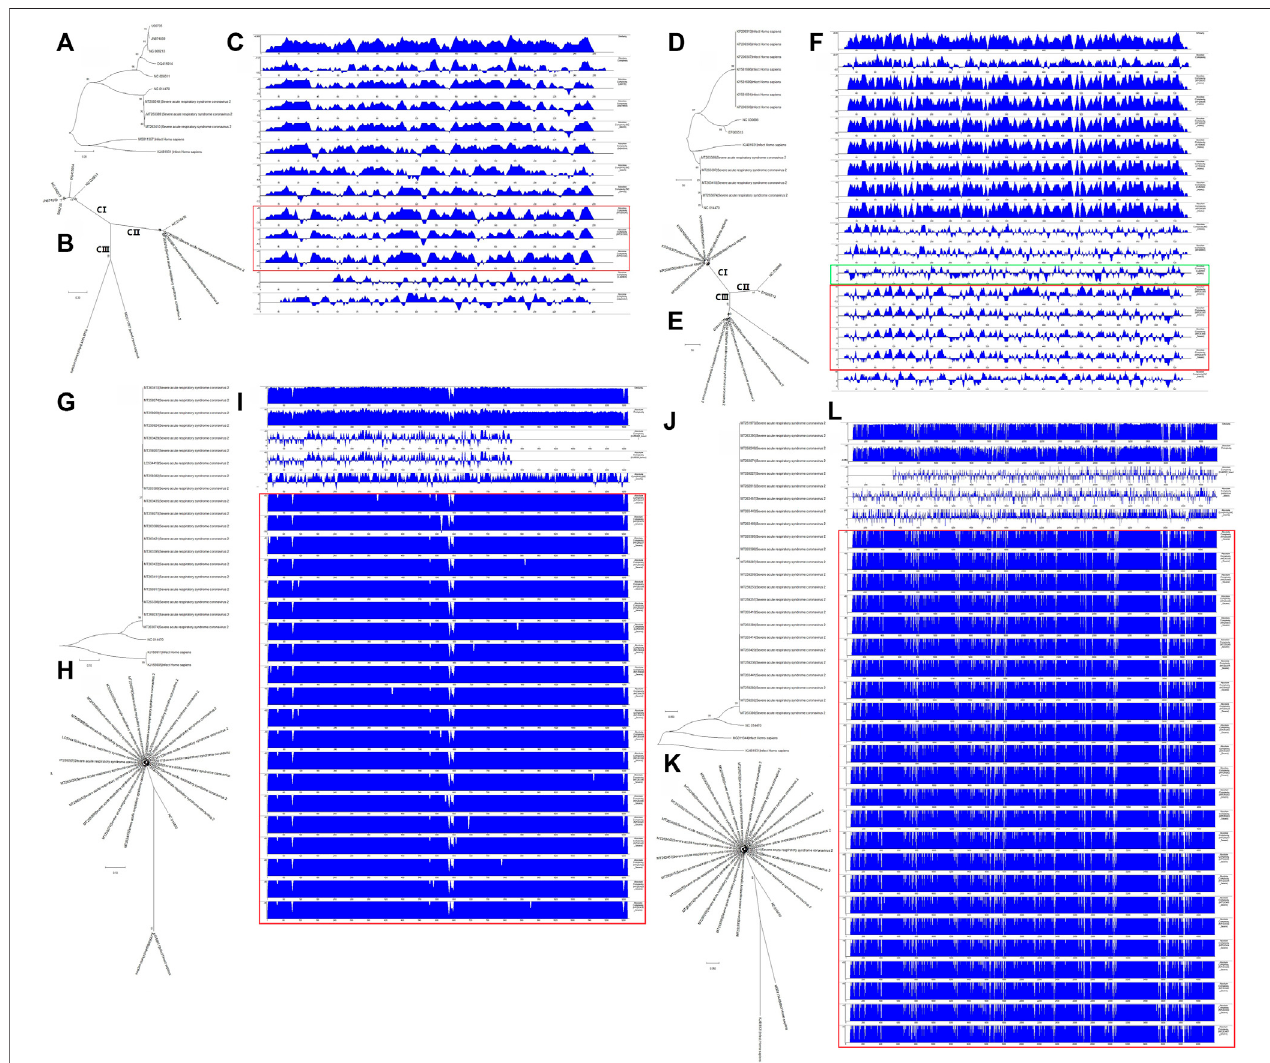
FIGURE5| Evolutionarycharacteristicsandabsolutediversitiesofstructuralgenesofsevereacuterespiratorysyndromecoronavirus-2(SARS-CoV-2)isolatesand commoncoronaviruses(C-CoVs). (A,B,D,E) :TheEand Mgenesequences ofSARS-CoV-2 isolatesandcommonCoVs couldbe grouped intothreeclades (CI, CIIand CIII). A, B: The E gene sequences of SARS-CoV-2 isolates and C-CoV NC014470 were evolutionary intermediates between C-CoVs that infect humans and other organisms. (C) :TheabsolutediversitiesofEgenesequencesofSARS-CoV-2isolatesweremoresimilartothoseofC-CoVsthatinfectotherorganisms. (D,E) :The M gene sequences of SARS-CoV-2 isolates, NC014470 (infecting other organisms) and KJ481931 (infecting humans) were closely related and grouped together in the same branch of a phylogenetic tree. The M gene sequences of SARS-CoV-2 isolates were evolutionary intermediates between those of NC014470 (infecting other organisms)andKJ481931(infectinghumans). (F) :TheabsolutediversitiesofMgenesequencesofSARS-CoV-2isolatesweremoresimilartothoseofC-CoVsinfecting other organisms. (F) (Green box): The absolute diversity of M gene sequences of KJ481931 (infecting humans) was more similar to those of M gene sequences from SARS-CoV-2 isolates and C-CoVs that infect other organisms. (G,H,J,K) : The N and S gene sequences of SARS-CoV-2 strains grouped closely together on the same branch of an evolutionary tree. (G,H,J,K) : The N and S gene sequences of NC014470 were located between those of SARS-CoV-2 isolates and C-CoVs that infect humans. (I,L) : The absolute diversities of N and S gene sequences of SARS-CoV-2 isolates were unlike those of